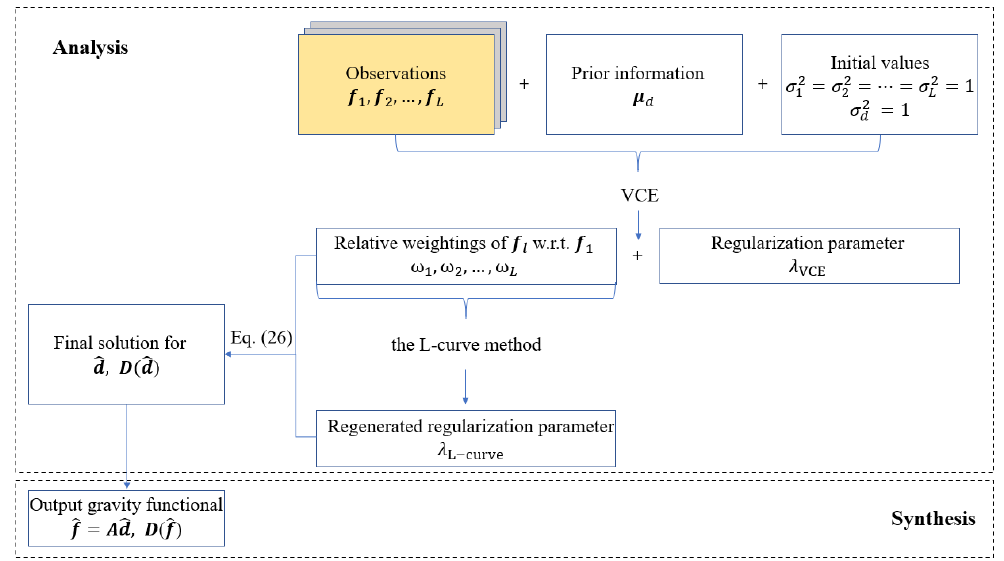
Figure 3. Analysis and synthesis for combining different types of observations based on the VCE-Lc.